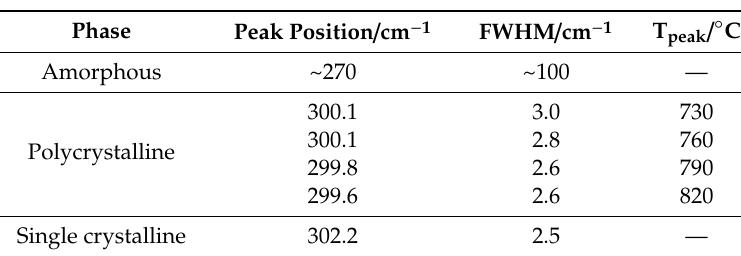
Table A1. Comparison of the Raman scattering spectra of a-Ge and poly-Ge, annealed at different temperatures, and a (100) c-Ge wafer. The peak position and full width at half maximum (FWHM) values were determined by fitting the measured data. The resolution during the measurement was 1.2 cm − 1 .